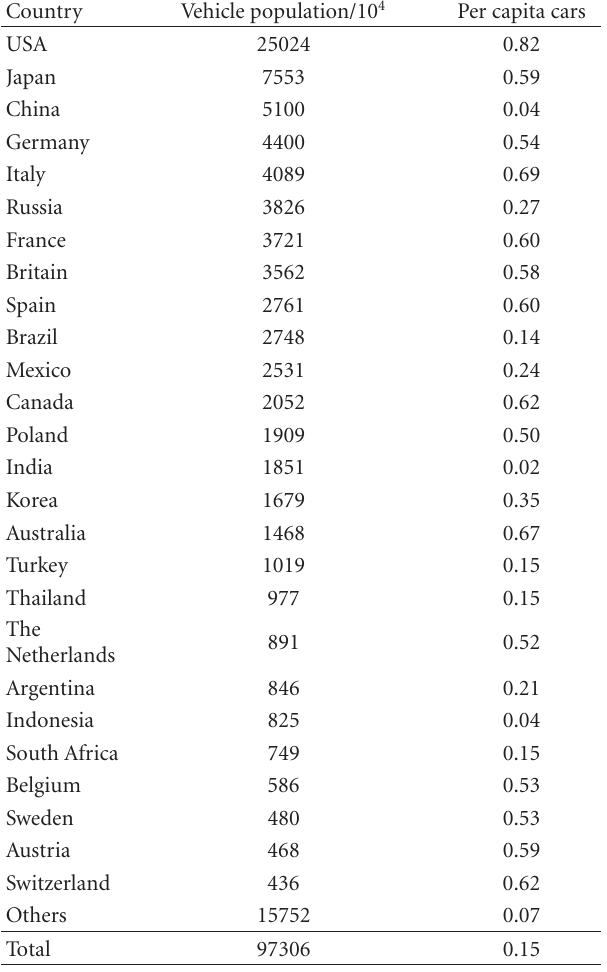
Table 1: Worldwide vehicle population and per capita car owner- ship in